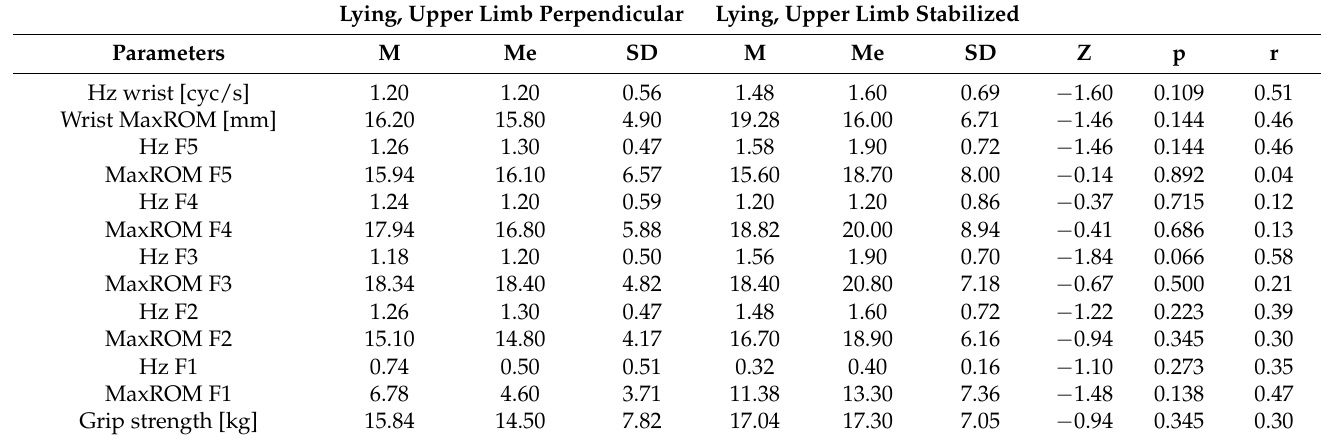
Table 11. Comparison of movement and strength parameters in the lying positions with upper limb upwards and against the body in the group of patients after cerebellar ischemic